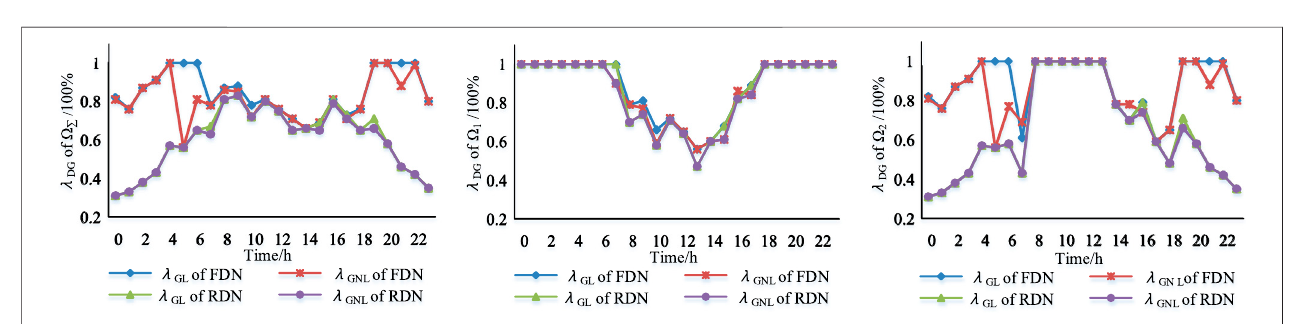
FIGURE 7 | Scenario 2: daily GLAR and GNLAR curve of both the FDN case and RDN case.